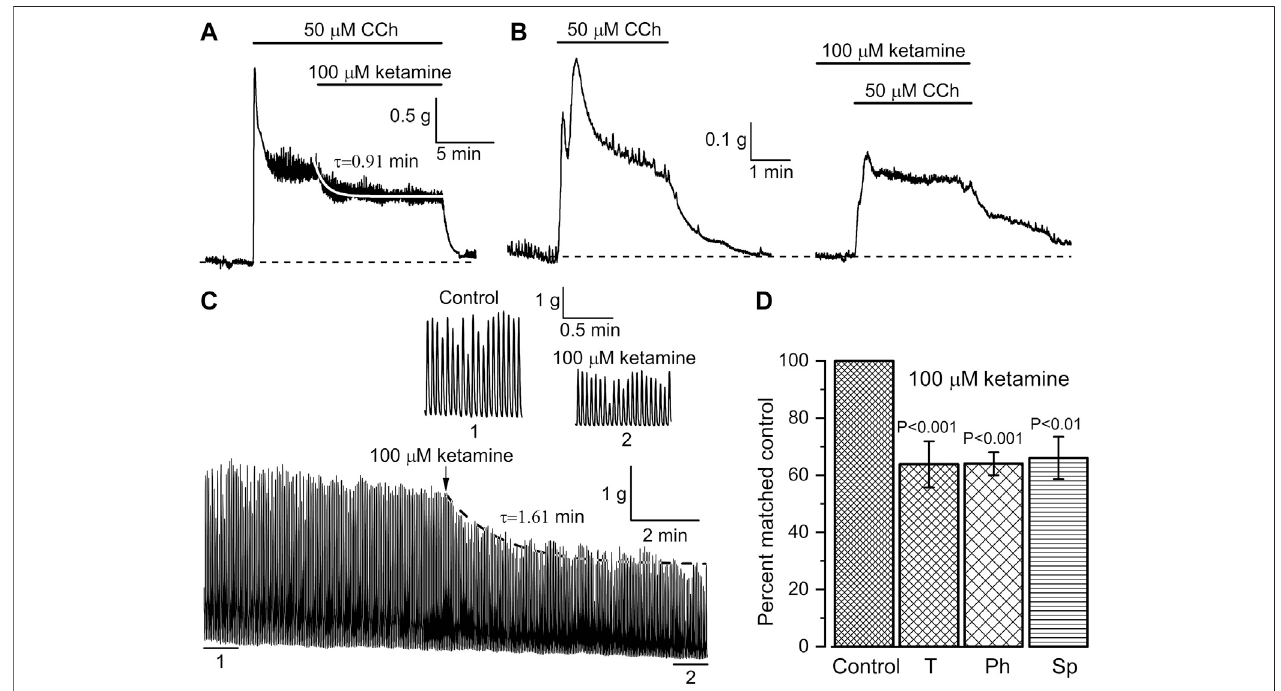
FIGURE 6 | Ketamine inhibits both CCh-induced and spontaneous mouse ileum contractions. (A , B) Representative traces illustrating isometric contractions of ileum segments in response to CCh (50 μ M) followed by ketamine application (100 μ M) in the continuous presence of CCh (A, n (cid:2) 9), or, alternatively, CCh application followingpretreatmentwithketamine(B, n (cid:2) 10).KetamineinhibitedtoniccomponentoftheCCh-inducedcontractionwithtimeconstantof0.91 ± 0.09 minasshownby the smooth white superimposed line in panel (A). (C) Ketamine (100 μ M) also inhibited spontaneous rhythmic contractions of the ileum with time constant of 1.61 min; 1 min duration segments marked 1 (control) and (2) at the steady-state inhibition by ketamine are shown on an expanded time scale. (D) Summary of the inhibitory effects of ketamine on tonic (T, n (cid:2) 9) and phasic (Ph, n (cid:2) 10) components of CCh-induced contractions of the ileum and on its spontaneous (Sp, n (cid:2) 7) contractions.